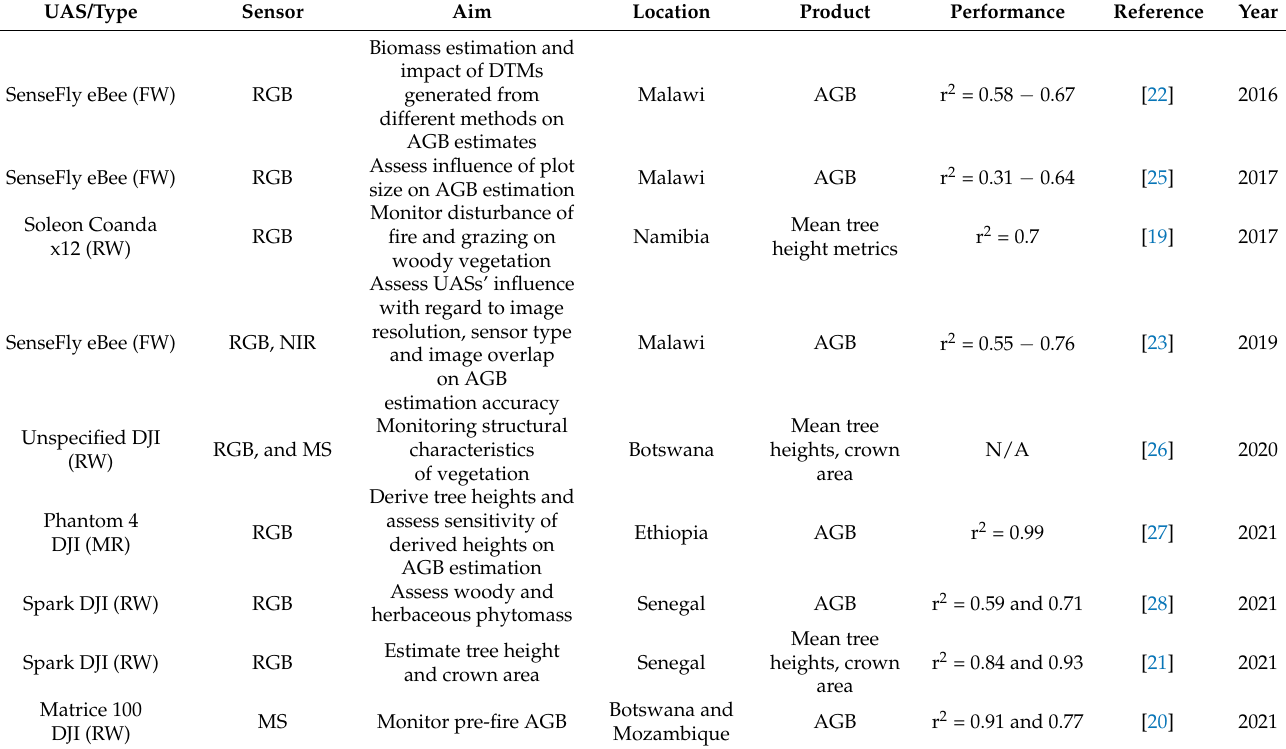
Table 2. Summary of studies that applied UASs in forestry in sub-Saharan Africa.